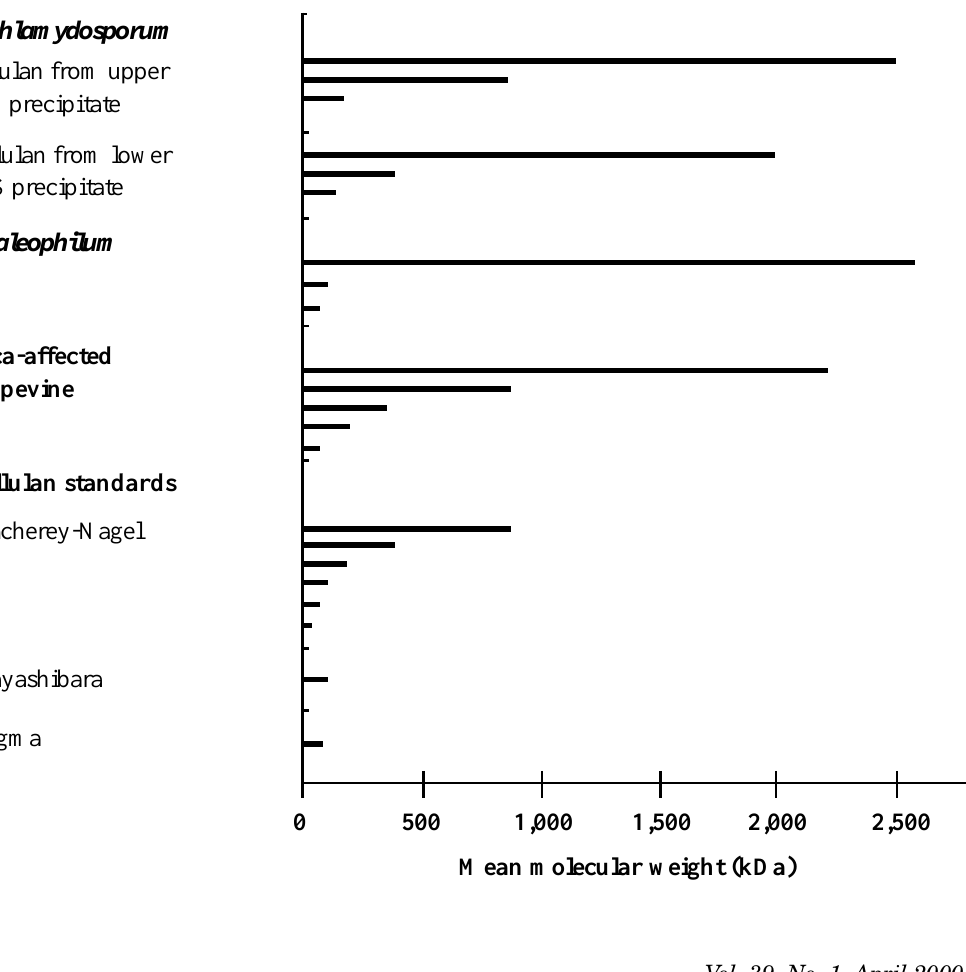
Table 3. Mean molecular weights of pullulan families purified from culture filtrates of P. chlamydosporum and P. aleophilum and from the woody tissue of an esca-affected cv. Sangiovese grapevine, as compared with commercial pullulan